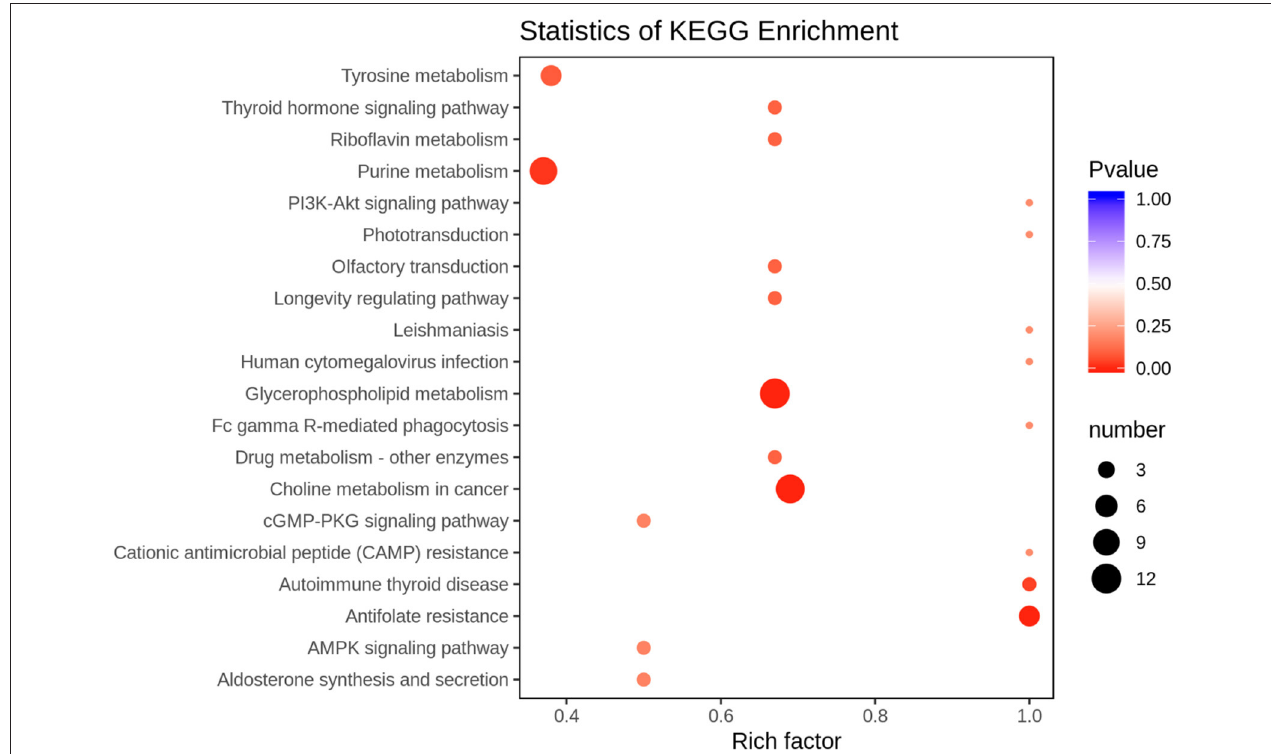
FIGURE 3 | Top 20 Kyoto Encyclopedia of Genes and Genomes (KEGG) pathway terms ( P < 0.05) enriched by differentially accumulated metabolites (DAMs). The X-axis means rich factor. The Y-axis represents the KEGG pathway terms.